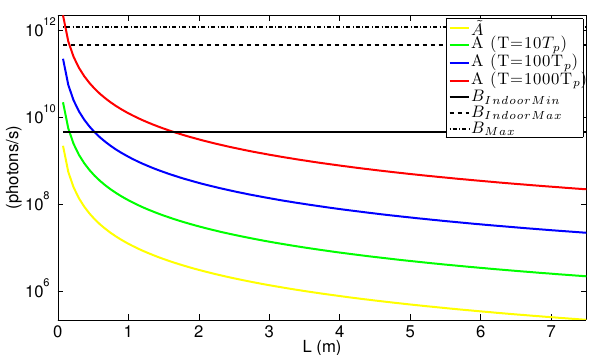
Figure 7. ˜ A and A values as a function of the distance between the target and the sensor. A values are shown for three different T .